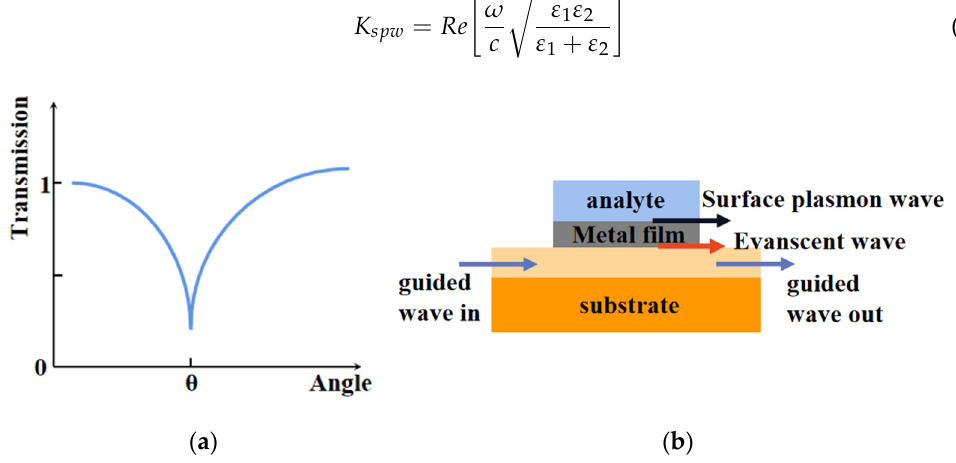
Figure 1. ( a ) Schematic diagram of SPR effect of double-layer metal film; ( b ) Model diagram of double-layer metal coating.